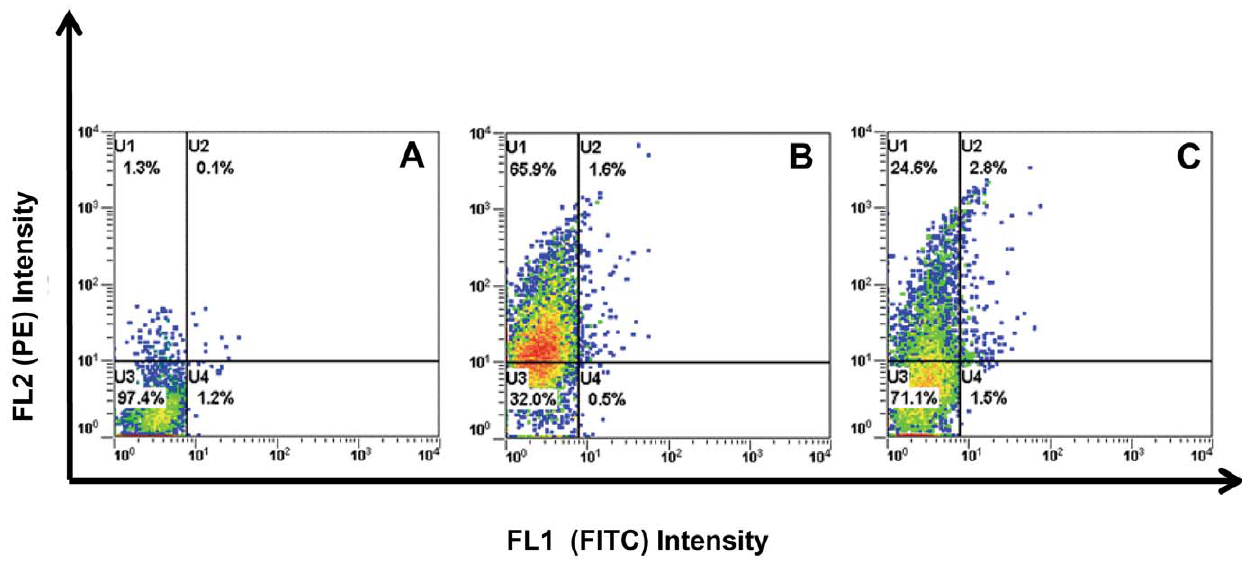
Figure 1. Expression profile of HA and Myc tagged GPI-TSHR-ecd receptors: HEK293 cells were transiently transfected with 1 ug of HA or Myc-GPI-TSHR-ecd plasmid cDNA and the cells were stained 48 hrs post-transfection with anti-HA or anti-Myc (1 ug/10 6 cells) antibody. This was followed by anti-mouse IgG Fab’ conjugated to phycoerthrin (PE) as secondary antibody. Density analysis for receptor expression under FL2 (PE) and FL1 (FITC) was performed using the Beckman Lab Quanta SC flowcytometer. Panel A ) Controls cells transfected with vector only and stained with primary and secondary antibodies. Panel B ) HA-GPI-TSHR-ecd transfected cells stained with anti-HA (66% positivity). Panel C ) Myc-GPI-TSHR-ecd transfected cells stained with anti-myc (25% positivity). Since tags are the N-terminus of the receptor ectodomain, unfixed cells were used for this staining.